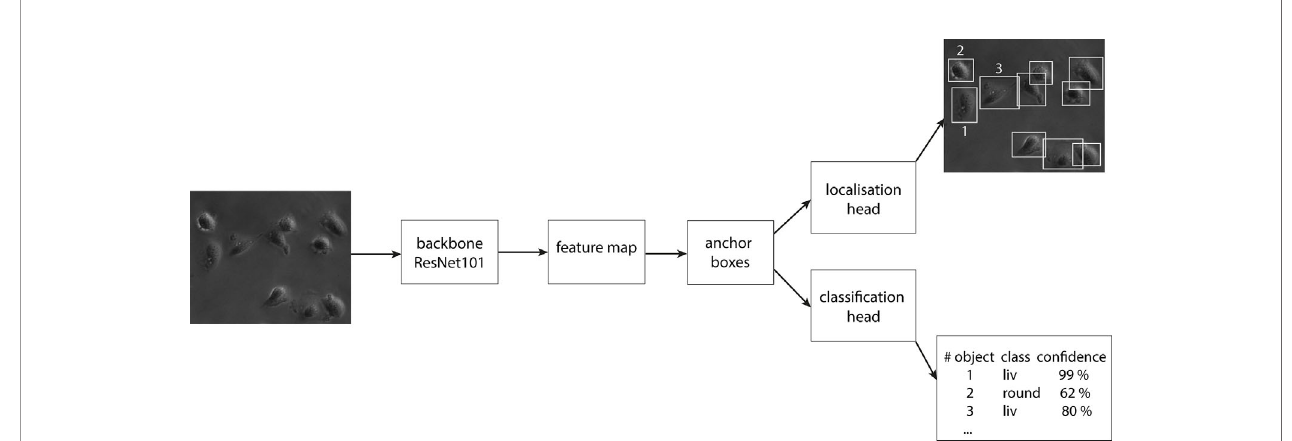
FIGURE 3 | The schematic design of faster RCNN as object